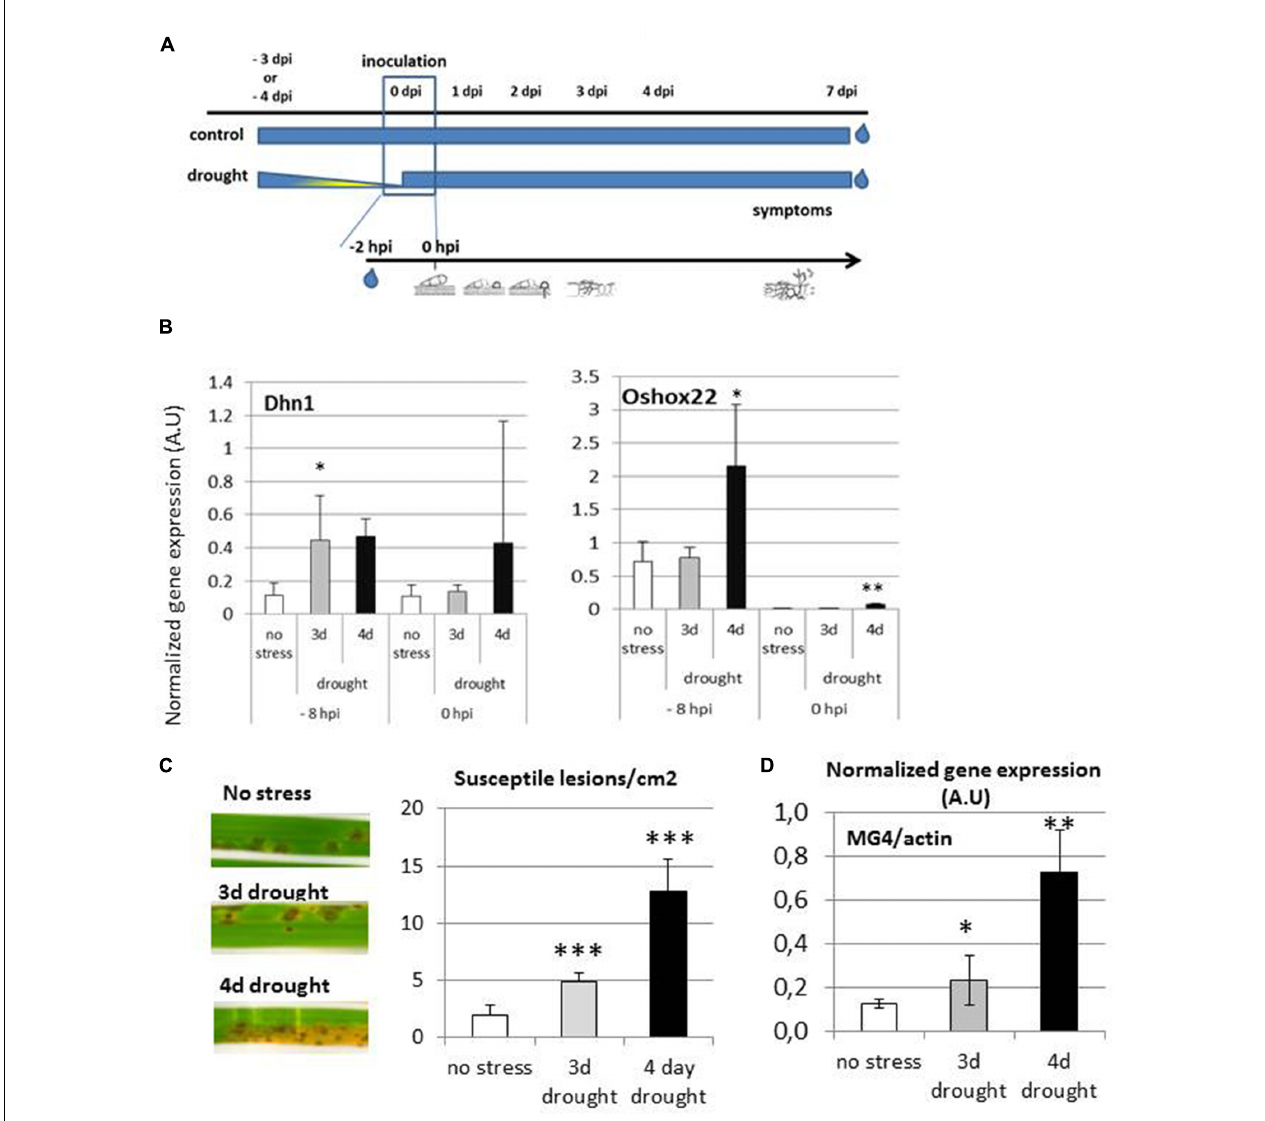
FIGURE 1 | Rice infection by Magnaporthe oryzae after drought stress. Three weeks old rice plants were subjected to drought stress and then spray inoculated with M. oryzae spores (FR13 isolate). Details of drought treatment, rehydration, inoculation, and sampling are schematically presented in panel (A) . (B) Expression of drought-inducible Dhn1 and Oshox22 marker genes before fungal inoculation. The expression was measured before re-watering ( − 8 hpi) and 2 h after re-watering (at the time of inoculation, 0 hpi). Gene expression was measured by RT-qPCR and normalized with the Actin gene (see Materials and Methods). (C) Macroscopic disease symptoms at 7 days after inoculation and the number of lesions per leaf surface. (D) Quantification of the disease symptoms presented in (C) using Q-PCR to measure fungal biomass (MG4 constitutive fungal gene) normalized with the constitutive Actin rice gene. Asterisks indicate significant differences to the well-watered control plants in the t -test ( ∗∗∗ P < 0.001, ∗∗ P < 0.01, ∗ P <